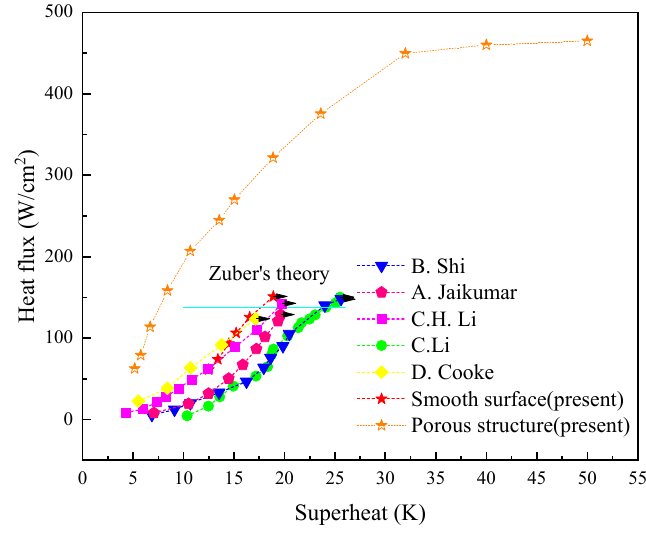
Figure 5. Boiling heat transfer performance curves for smooth and porous surfaces.